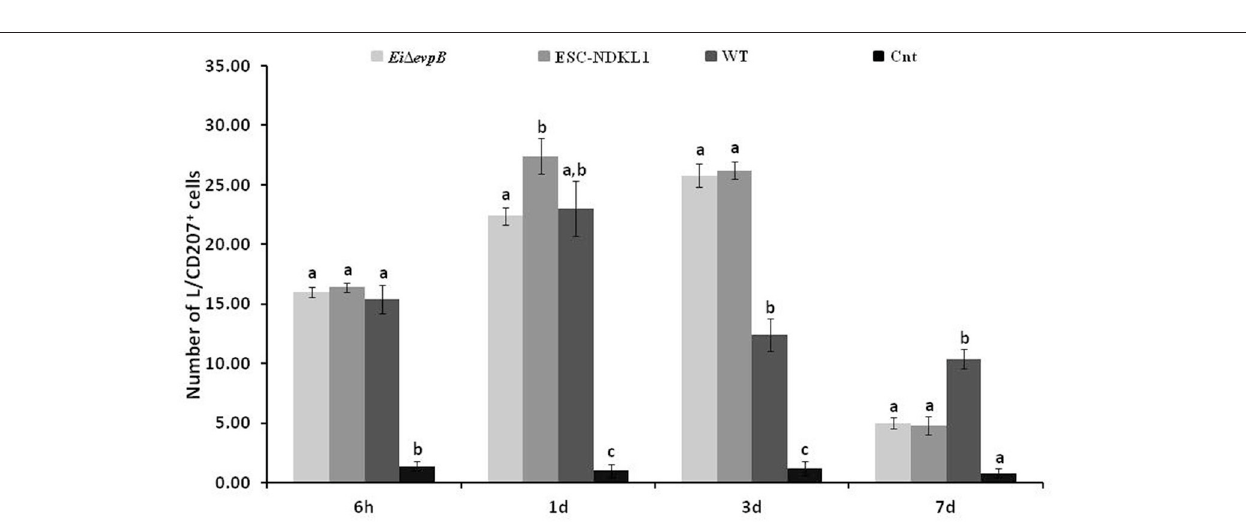
site of infection, and two LAVs were more efficient at inducing DC numbers compared to their WT counterpart.